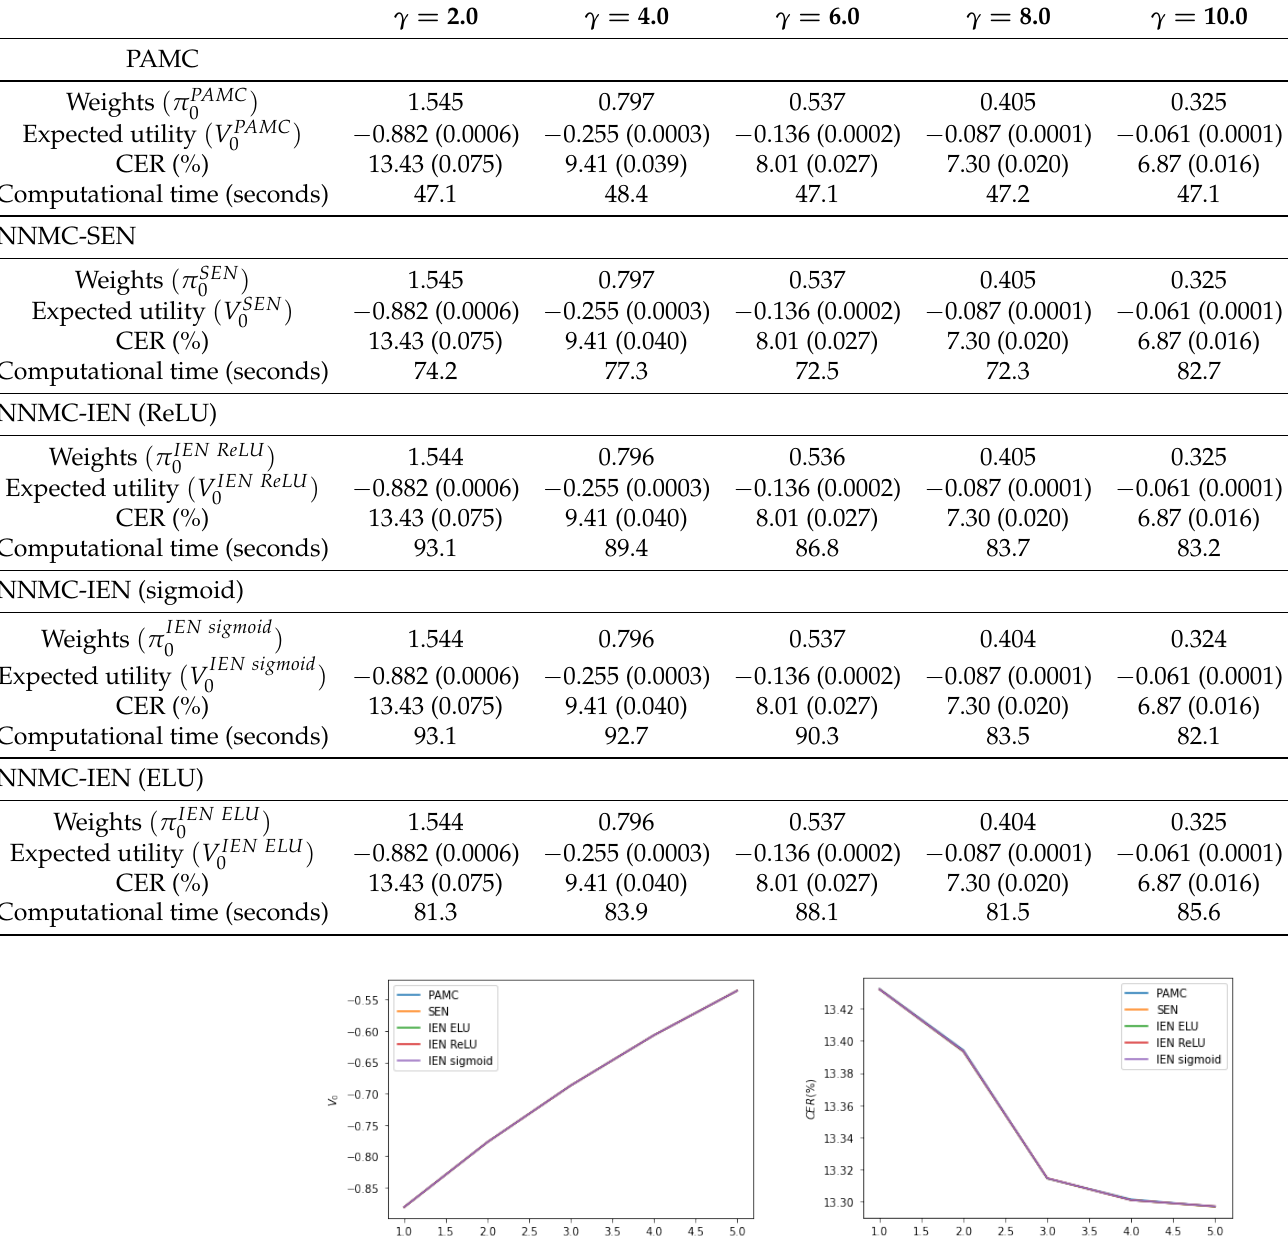
Table 4. Results for the 4/2 model with stochastic jumps. We report the optimal weights, expected utility and CER obtained via the approximation methods for different levels of risk aversion γ . The standard deviation of estimated expected utility and CER from 100 runs is displayed in parentheses.